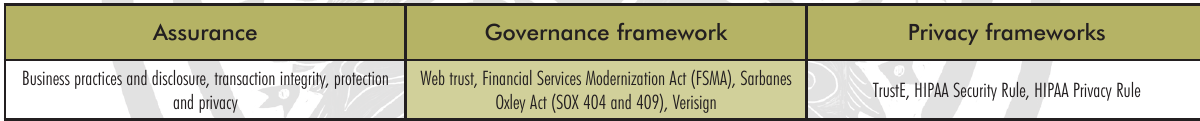
GOVERNANCE AND PRIVACY